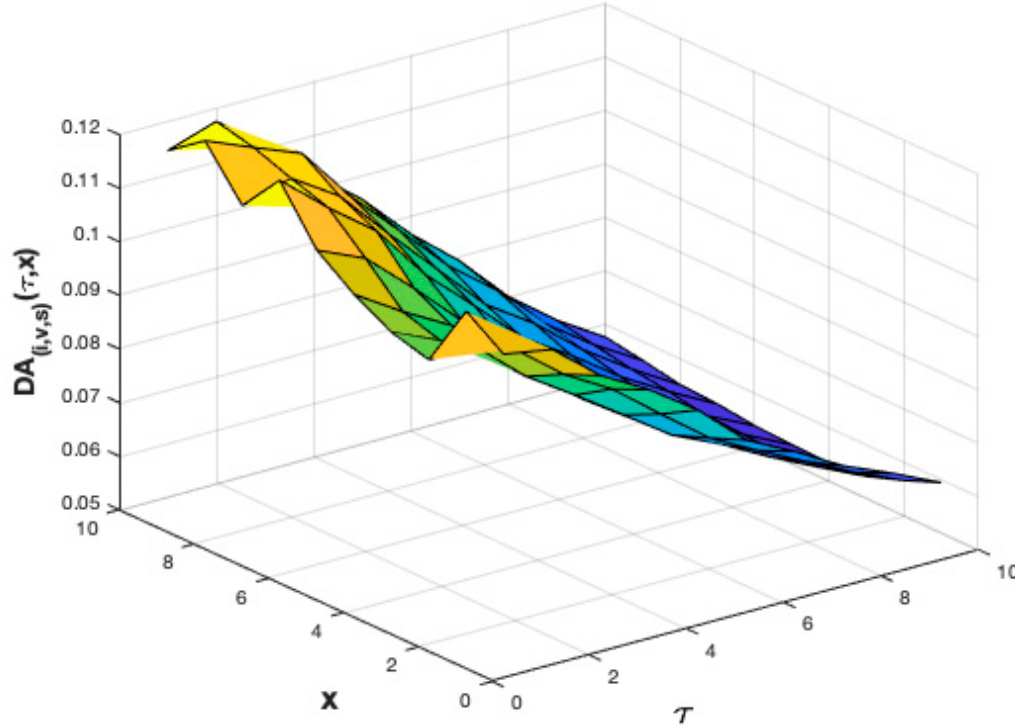
Figure 4. Duration dependent Availability, i = U, v = 3, and s = 0.